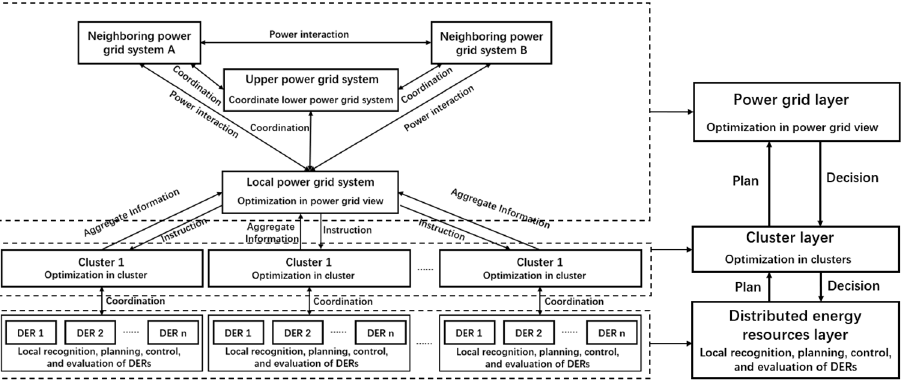
Figure 1. A typical process of interaction of plans and decisions among DERs ‐ clusters’ power grids.